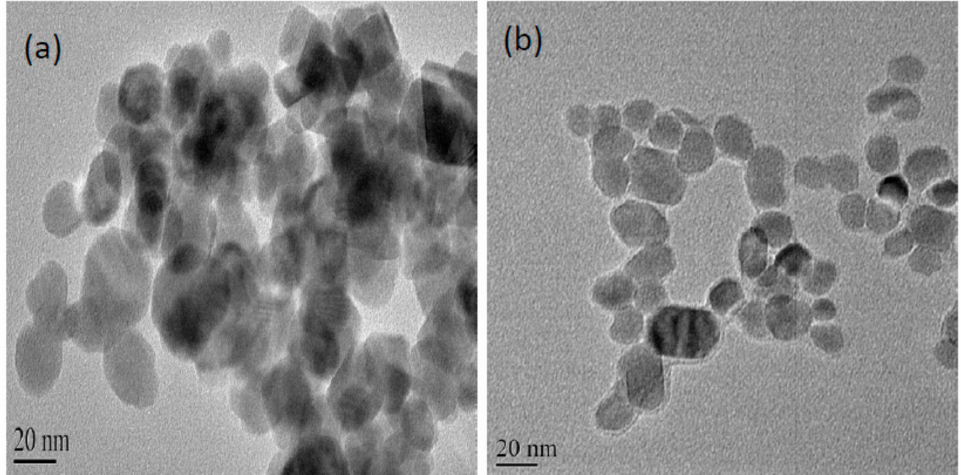
Figure 1. TEM images of functionalised magnetic nanoparticle ( a ) and nanoparticle immobilised lipase ( b ). Nanoparticle immobilised lipase ( b ) showed the uniform coating of protein as compared to the pristine nanoparticle ( a